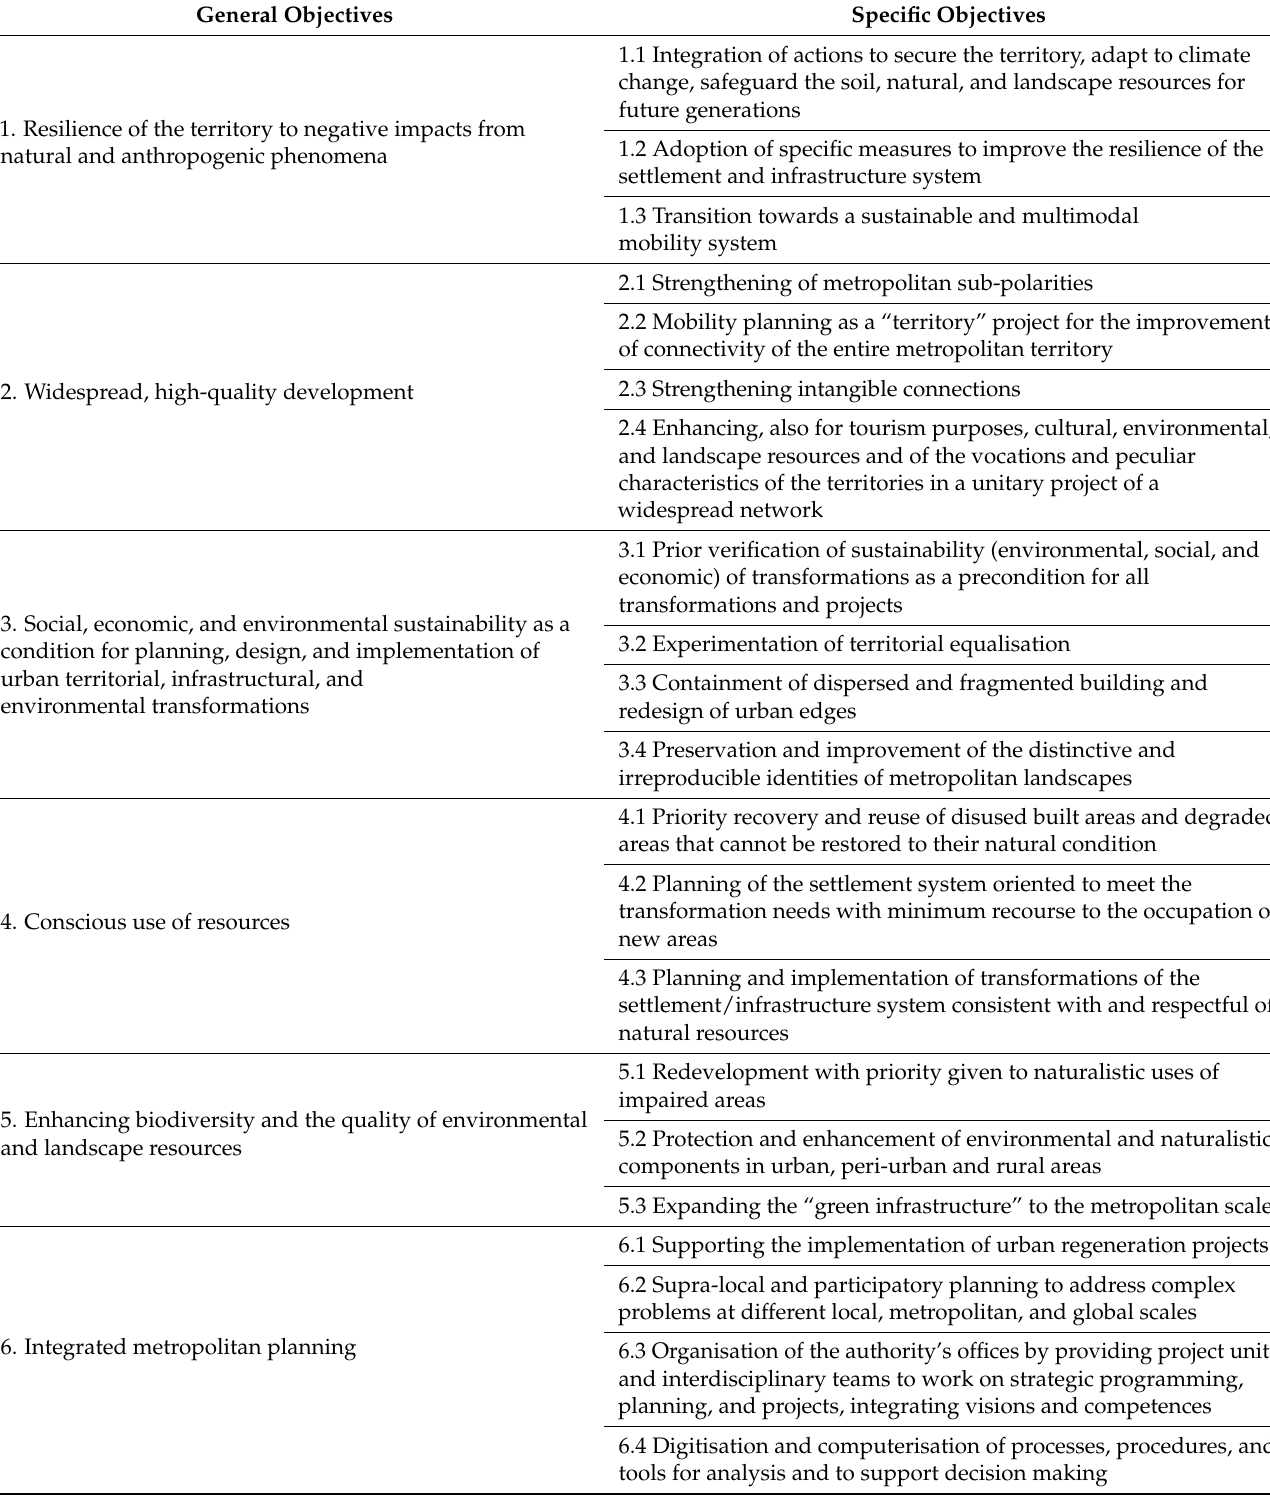
Table 14. Strategic framework of the PTGM